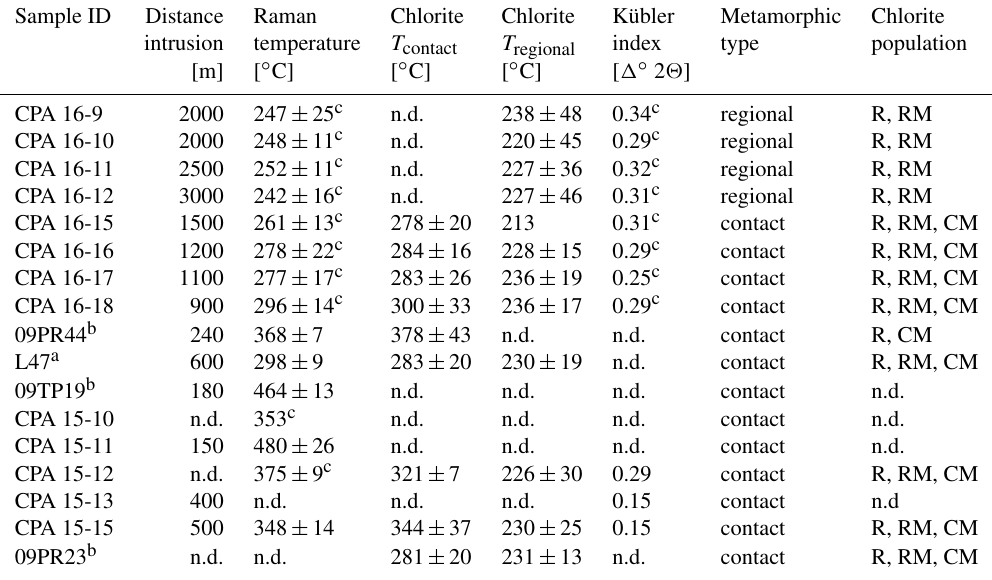
Table 1. Compilation of results from Raman spectroscopy on carbonaceous matter, chlorite geothermometry, and illite “crystallinity” (Kübler index) for the < 2µm fraction. n.d.: not determined; R: retrograde; RM: regional metamorphic; CM: contact metamorphic.